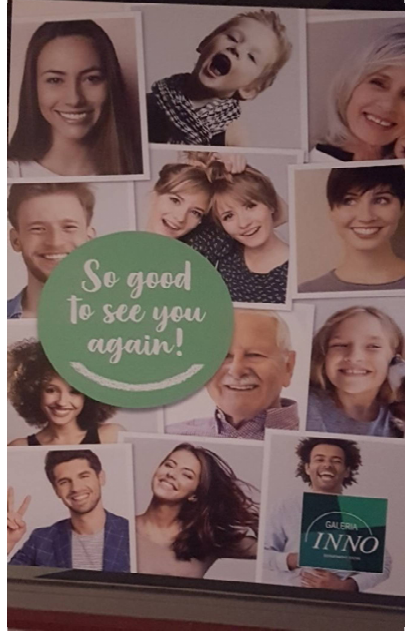
Figure 13. So good to see you again! One final observation in this subset of welcoming messages concerns the language being used. Of the nine cases presented here, four are entirely in English ( Welcome